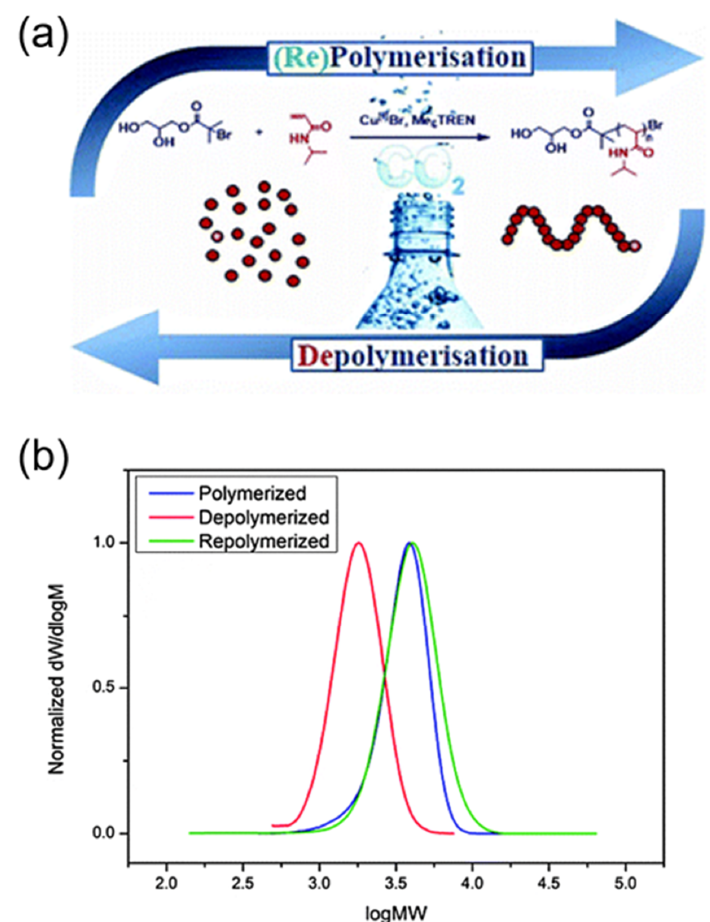
Figure 8. Reversible polymerization in copper-mediated controlled polymerization system. ( a ) A schematic illustration of aqueous reversible polymerizations mediated by a copper catalyst and CO 2 ; ( b ) Gel permeation chromatography GPC traces of original poly ( N -isopropylacrylamide) (PNIPAM) (blue), depolymerized PNIPAM (red), and repolymerized PNIPAM (green). Reproduced with permission from [65] .